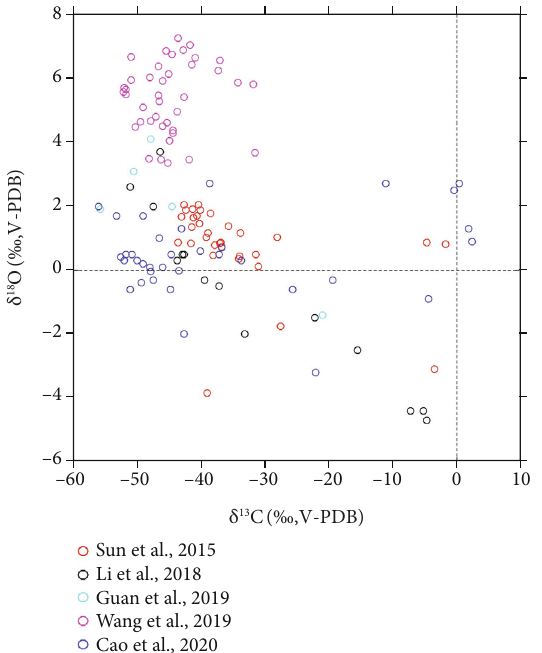
Figure 9: The diagram of the documented δ 13 C and δ 18 O values of seep carbonates in the Okinawa